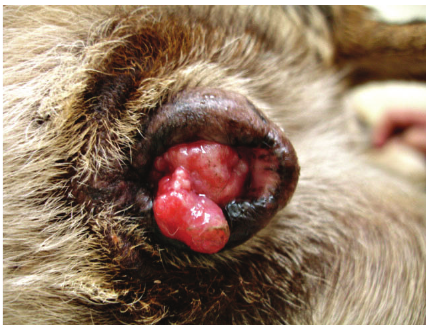
Figure 4: Dog. Photomicrograph of vaginal mucosa and canine venereal tumor cells (red arrow); accompanying inflammatory infil- trate within the subepithelial stroma was composed of lymphocytes, plasma cells, few neutrophils, and amastigote-laden macrophages (black arrow) which are shown in higher magnification in the inset (H&E, 40x and 63x).